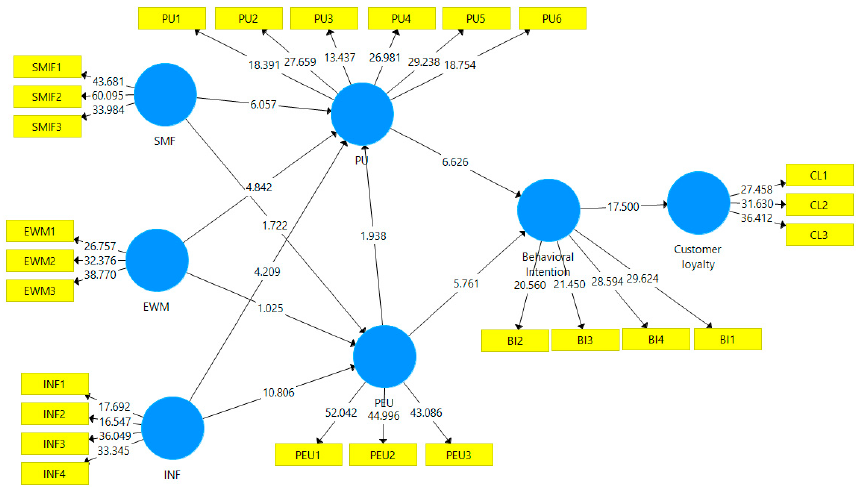
Figure 3. The model with bootstrapping mode, t -value.